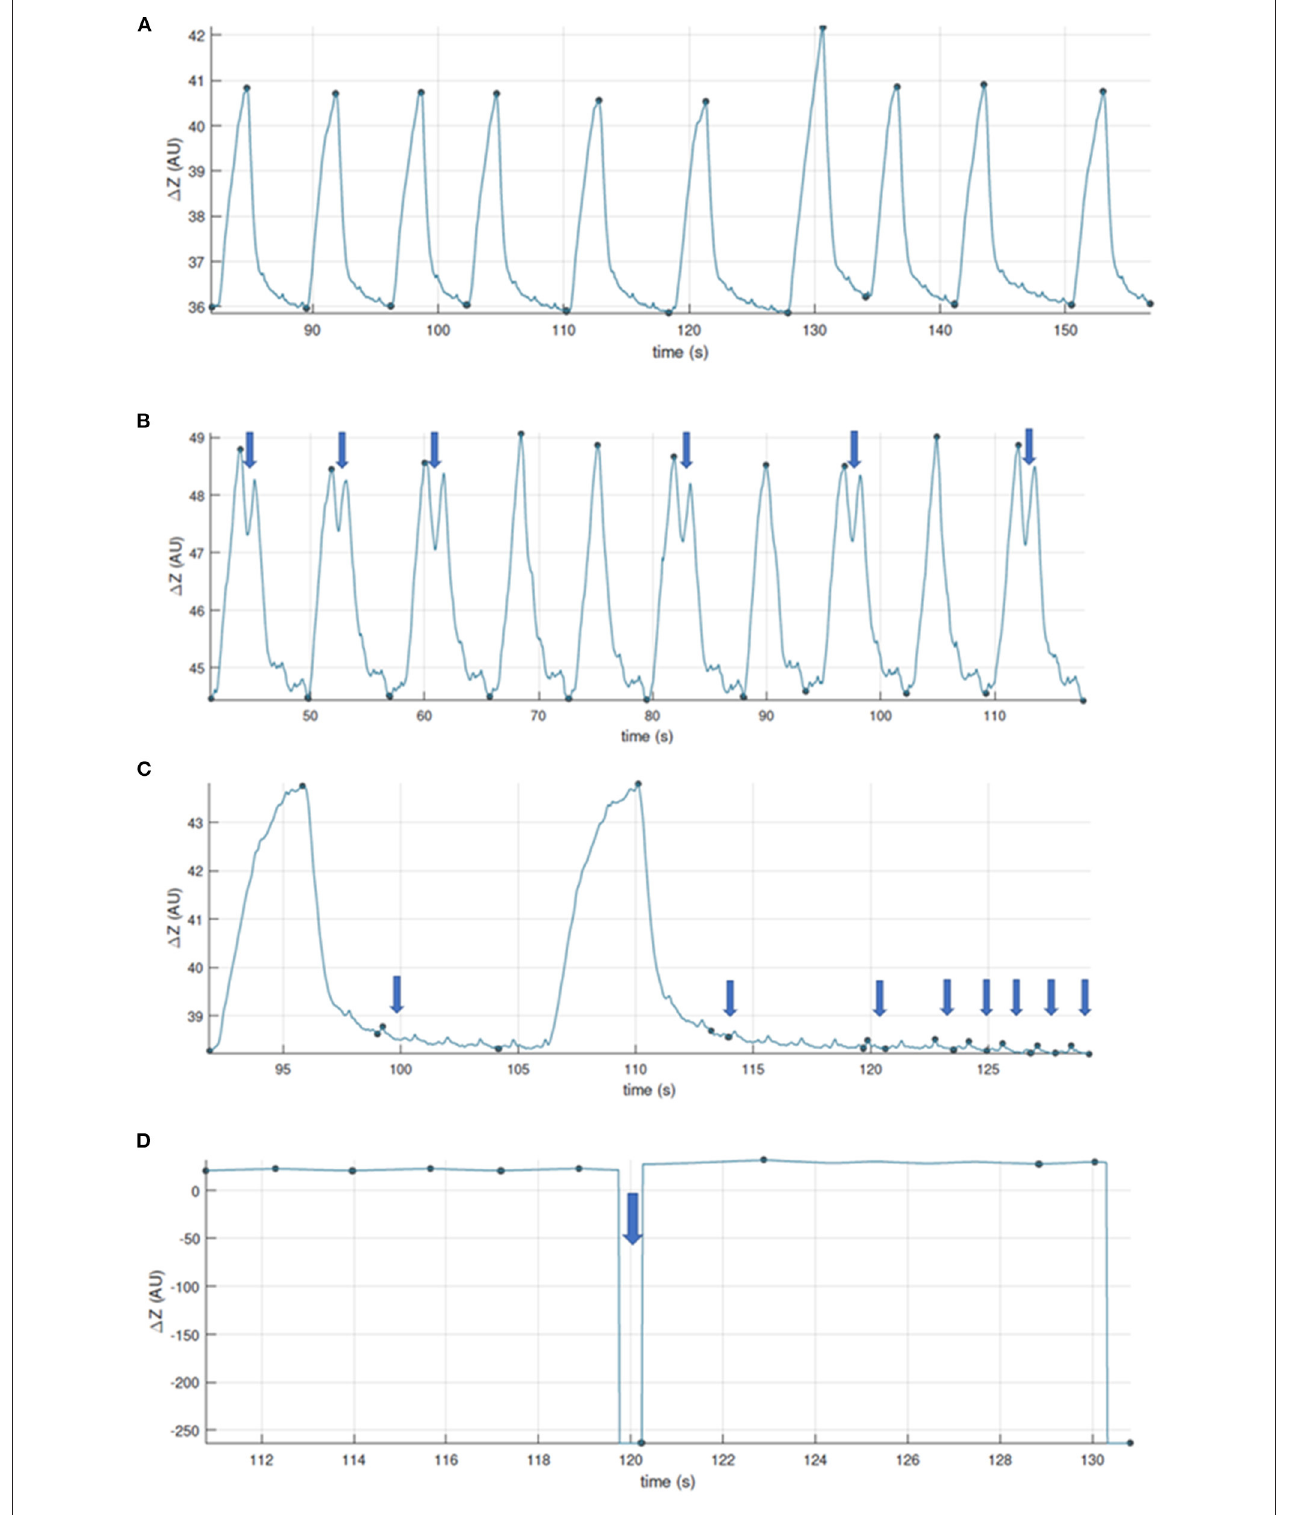
FIGURE 9 | Examples to aid with inclusion and exclusion of EIT breaths for further analysis. (A) Good quality recording, artifact free. (B) Good quality recording showing some two-stage breaths. These breaths can be included if they were observed and recorded as special breaths*. Video-recording thoracic excursions